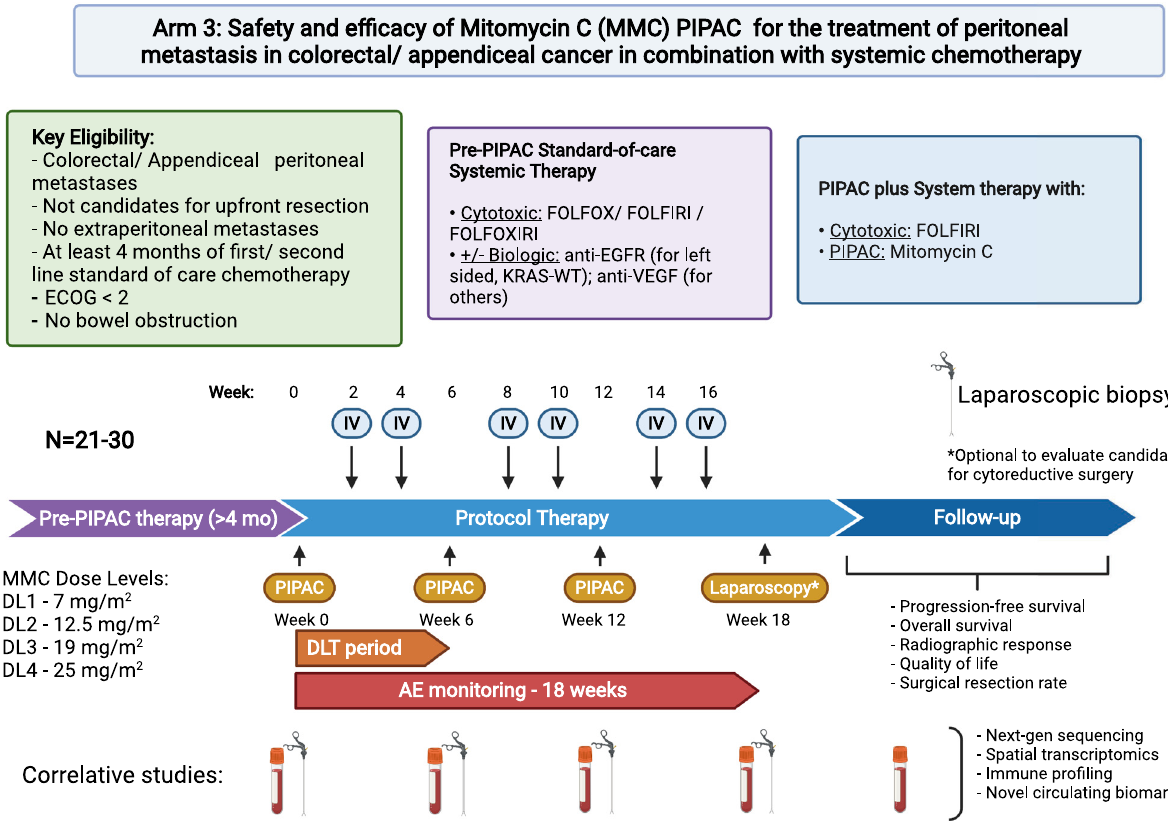
Figure 1: Study schema. Schema and overview of the Phase I trial of mitomycin C PIPAC in combination with systemic chemotherapy for colorectalandappendicealcancers.ThreePIPACproceduresareplanned6weeksapartwithtwodosesofIV systemicchemotherapy(FOLFIRI) every two weeks between PIPAC procedures. The starting dose of mitomycin C will be 7 mg/m 2 and escalate to 12.5, 19, and fi nally 25 mg/m 2 . Following the procedures, progression-free survival, overall survival, radiographic response, quality of life, and treatment with cytoreductive surgery will be monitored. Samples will be taken at each PIPAC procedure for correlative transcriptional and genomic studies. PIPAC, pressurized intraperitoneal aerosolized chemotherapy; FOLFOX, folinic acid (leucovorin), fluorouracil (5-FU), oxaliplatin; FOLFIRI, folinicacid(leucovorin),fluorouracil(5-FU),irinotecan;MMC,mitomycinC;FOLFOXIRI,folinicacid(leucovorin),fluorouracil(5-FU),oxaliplatin, irinotecan; AE, adverse event; DLT, dose limiting toxicity; ECOG, Eastern Cooperative Oncology Group; IV, intravenous; DL, dose level